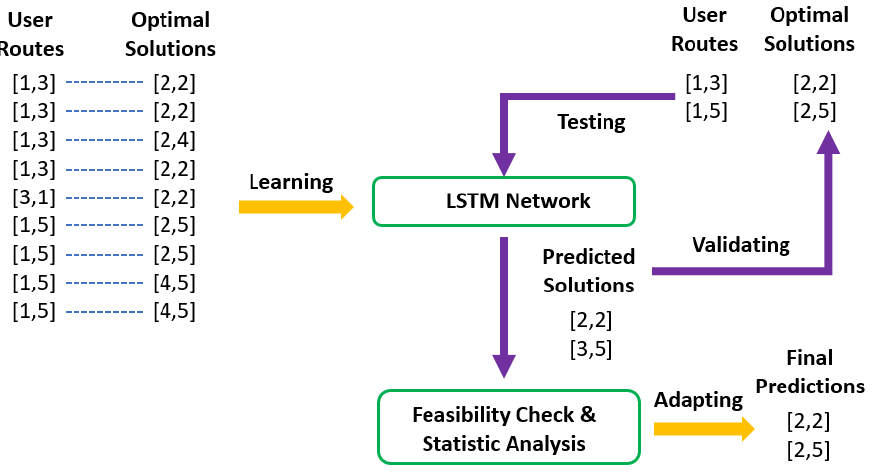
Figure 4. A Toy Example of the LSTM-based